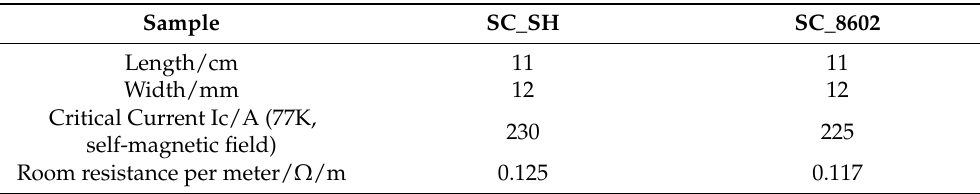
Table 1. Parameters of Superconductor Tapes.